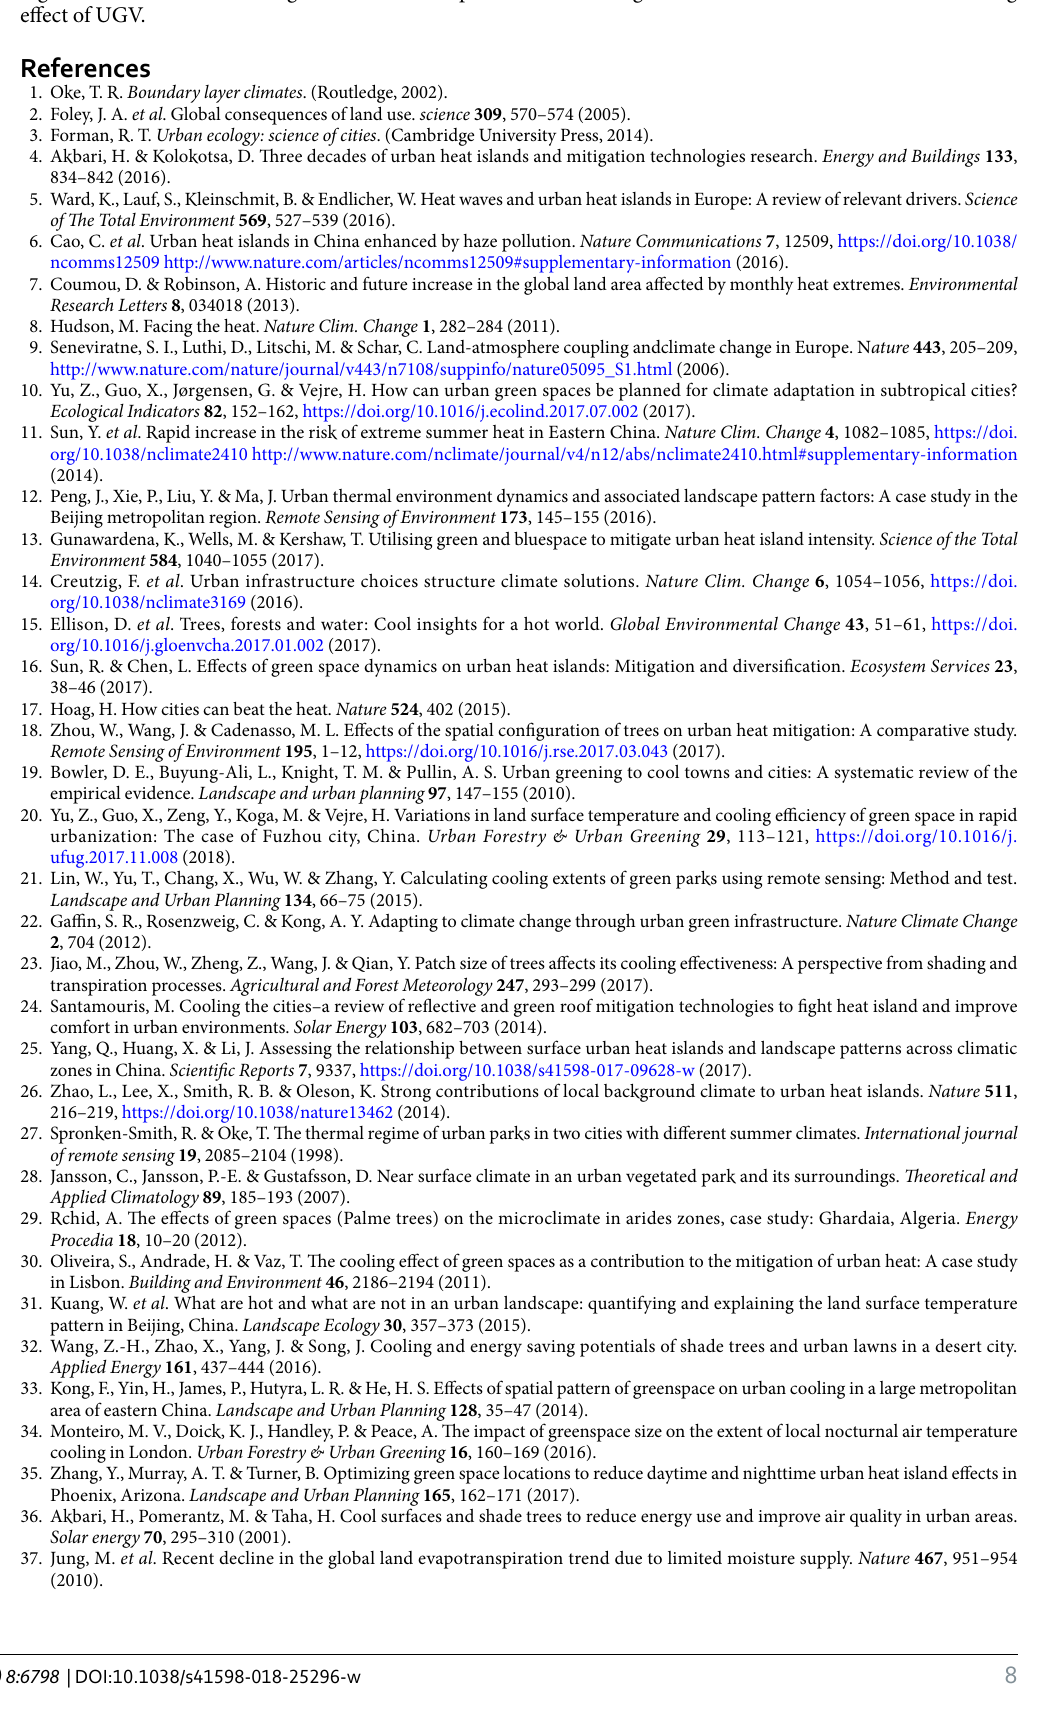
= where band data were obtained from the Landsat 8 images 31,45 . After excluding the influencing factors, linear regression was used to investigate the relationship between the background climate conditions and the cooling effect of